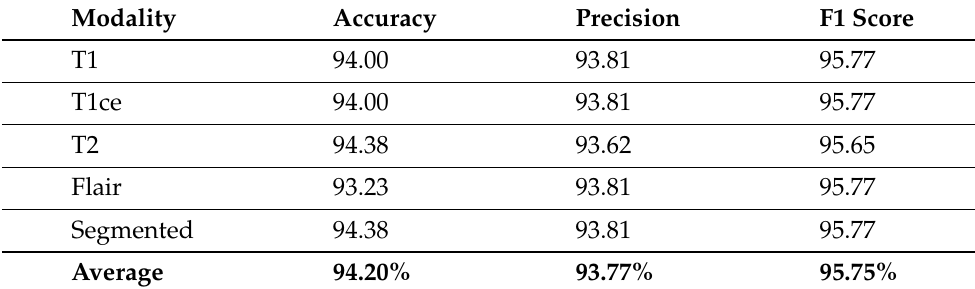
Figure 7. Example of a segmented 3D image in sagittal, coronal, and axial images. Table 3. Performance of modality-wise